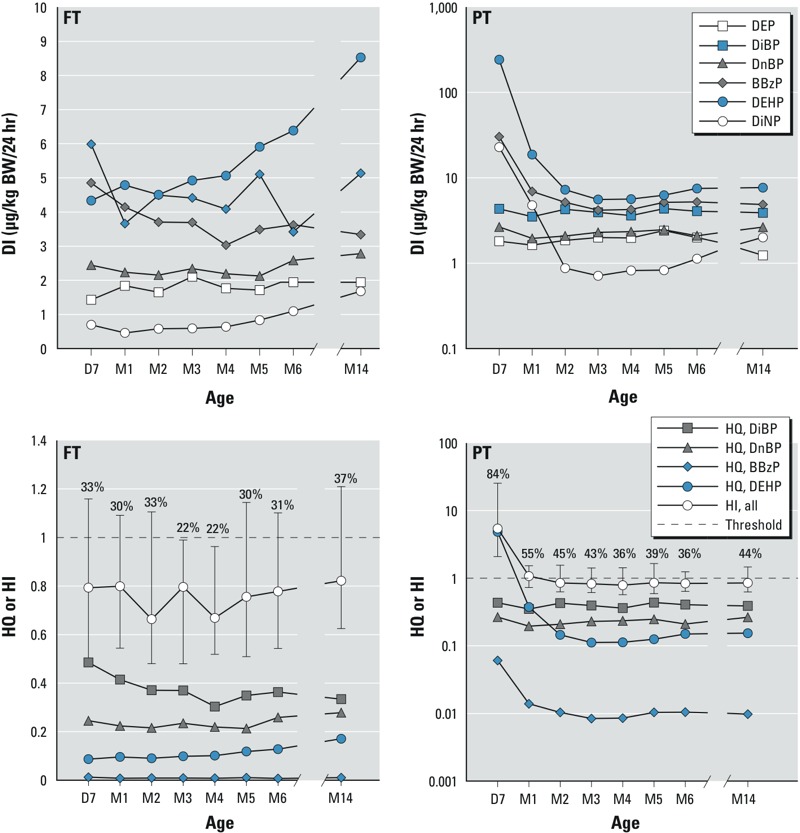
Median daily intake (DI), hazard quotient (HQ), and hazard index (HI) of phthalate diesters in FT (D7, n = 49; M1, n = 53; M2, n = 54; M3, n = 50; M4, n = 51; M5, n = 50; M6, n = 49; M14, n = 41) and PT (D7, n = 38; M1, n = 47; M2, n = 51; M3, n = 58; M4, n = 56; M5, n = 61; M6, n = 61; M14, n = 45) infants according to age [day (D) and month (M)]. BW, body weight. Median DIs are shown for the phthalate diesters (upper figures), and median levels of HQ and HI (error bars indicate the 25th–75th percentiles) are shown for DiBP, DnBP, BBzP, and DEHP (lower figures). The dashed line indicates the antiandrogenic threshold value (HI = 1), and values above error bars indicate the percentage of infants exceeding HI (HI was defined by summed ratios of estimated daily intakes to TDI based on EFSA recommendations). See Supplemental Material, Table S4, for corresponding numeric data.